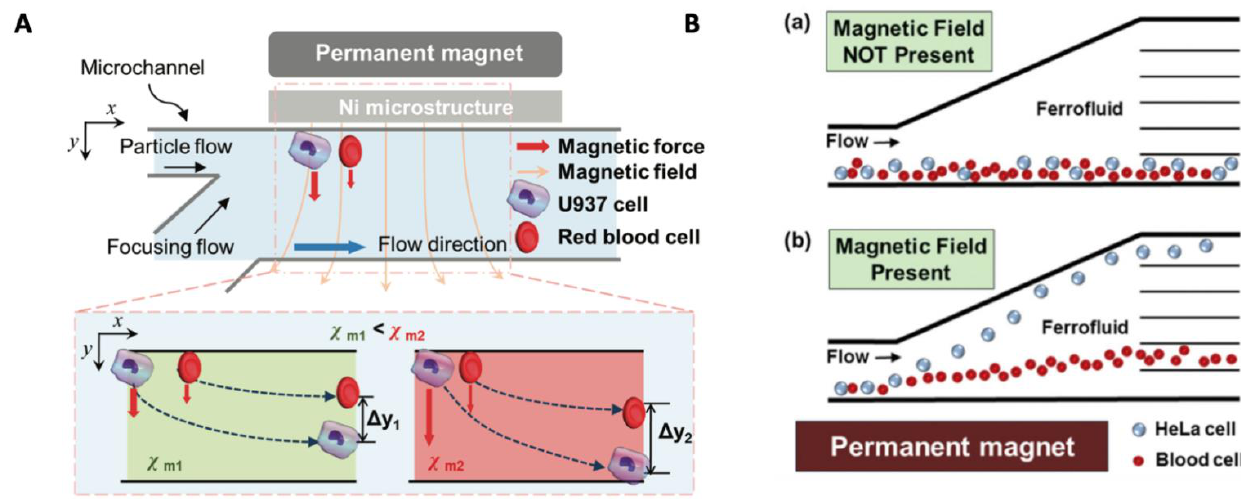
Figure 9. Label-free magnetic cell sorting. ( A ) Microfluidic cell separation based on the difference in magnetic repulsive forces between two cells of different size in a paramagnetic salt solution. The separation efficiency can be enhanced by increasing medium magnetic susceptibility from χ m1 to χ m2 . Reprinted with permission from [74]. Copyright © 2012, American Chemical Society. ( B ) Illustration of cell separation in a ferrofluid. HeLa cells and smaller blood cells are deflected from their laminar flow paths towards two different outlets by magnetic repulsion forces. Reprinted with permission from [79]. © 2015 WILEY-VCH Verlag GmbH & Co. KGaA, Weinheim.